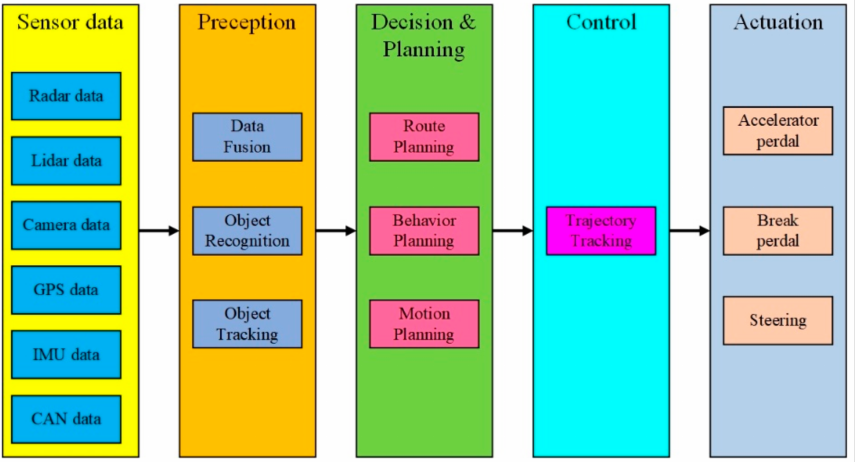
Figure 1. General framework of an autonomous driving system comprising perception, decision and planning, control and